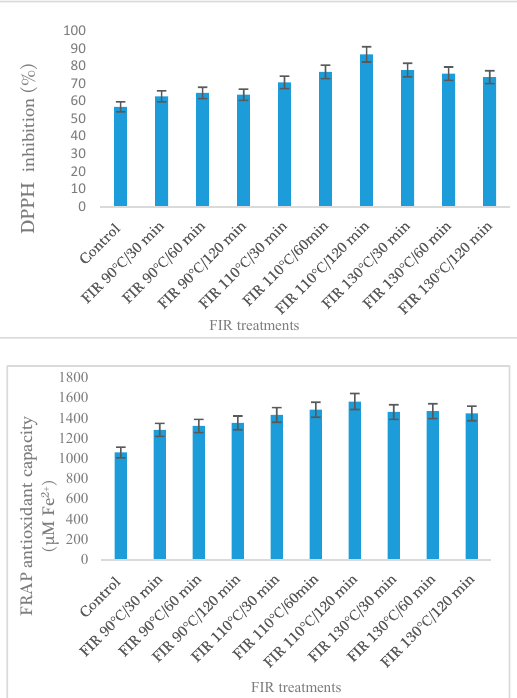
Figure 4. Antioxidant capacity (DPPH and FRAP) of soybean sprout under FIR treatment. The values are mean ± SE. ( n = 3). FIR: far infrared irradiation.